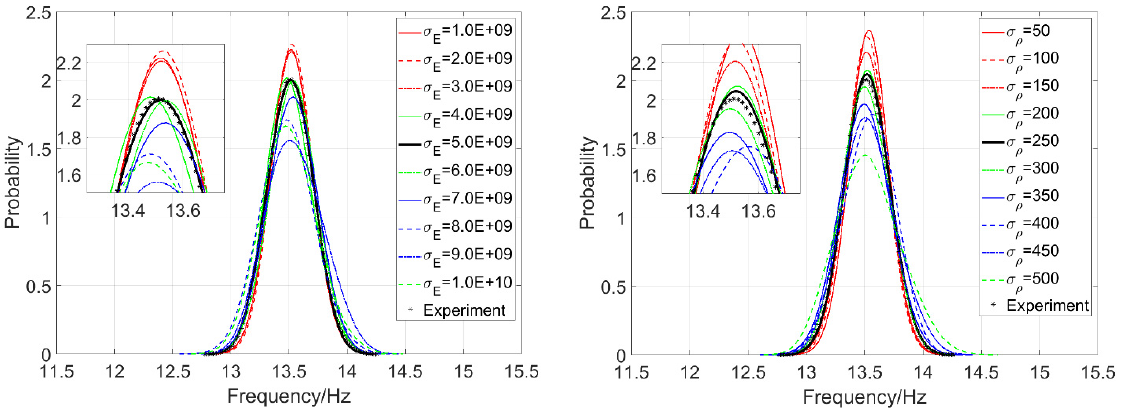
ρ f Figure 12. The two-dimensional kernel density estimation of 2 when both E and are ran- Figure 12. The two-dimensional kernel density estimation of f 2 when both E and ρ are random fields. dom fields. (cid:0) (cid:1) = (cid:0) (cid:1) σ ρ , L ρ x , L ρ y σ ρ , 500 mm, 500 mm and θ ρ = , and, respectively, taking σ ρ as 50 kg/m 3 , 100 kg/m 3 , . . . , 500 kg/m 3 for computing, and then taking parameter settings of test = ( 5 GPa, 500 mm, 500 mm ) and θ = (cid:0) 250 kg/m 3 , 500mm, 500 mm (cid:1) , the samples θ E 0 ρ 0 2D kernel density distribution function of f 2 is estimated as shown in the right part of Figure